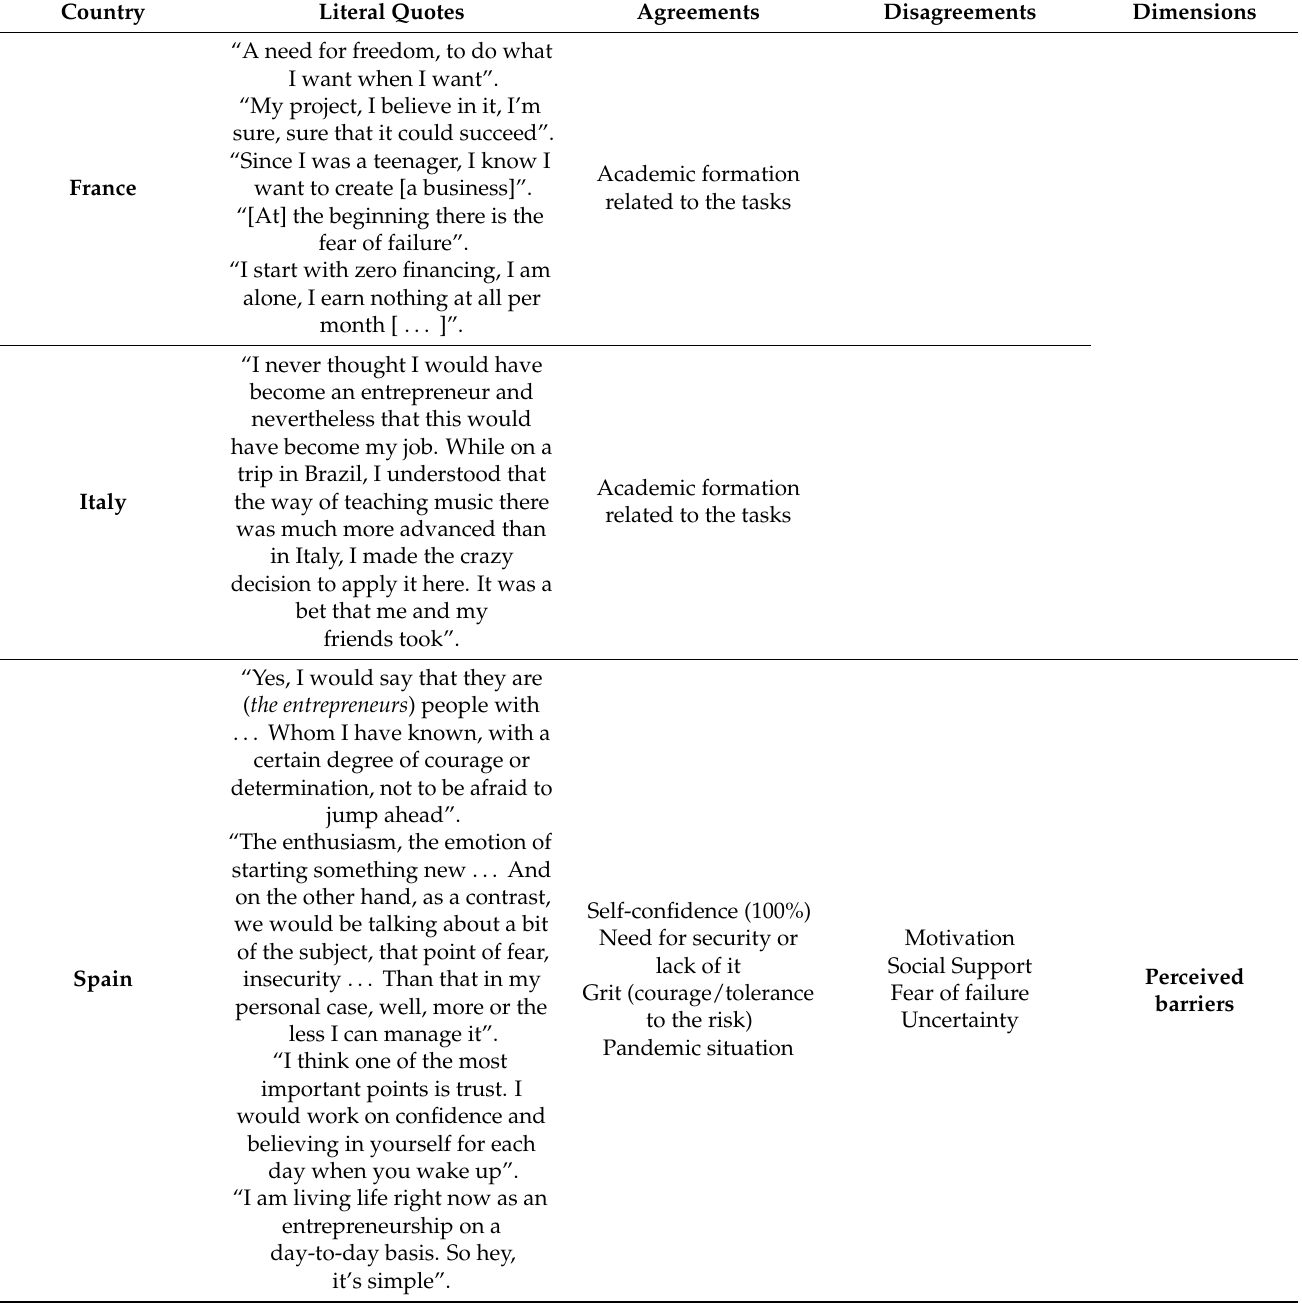
Table A2. Cont. Country Literal